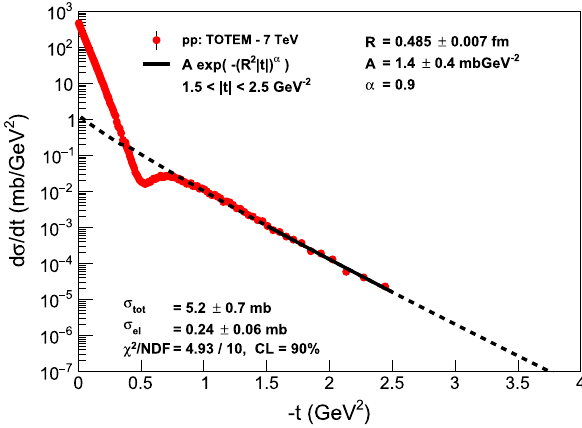
Fig. 34 Zeroth-order Lévy fits to the tail of the differential cross- section data on pp elastic scattering at A and R as free fit parameters